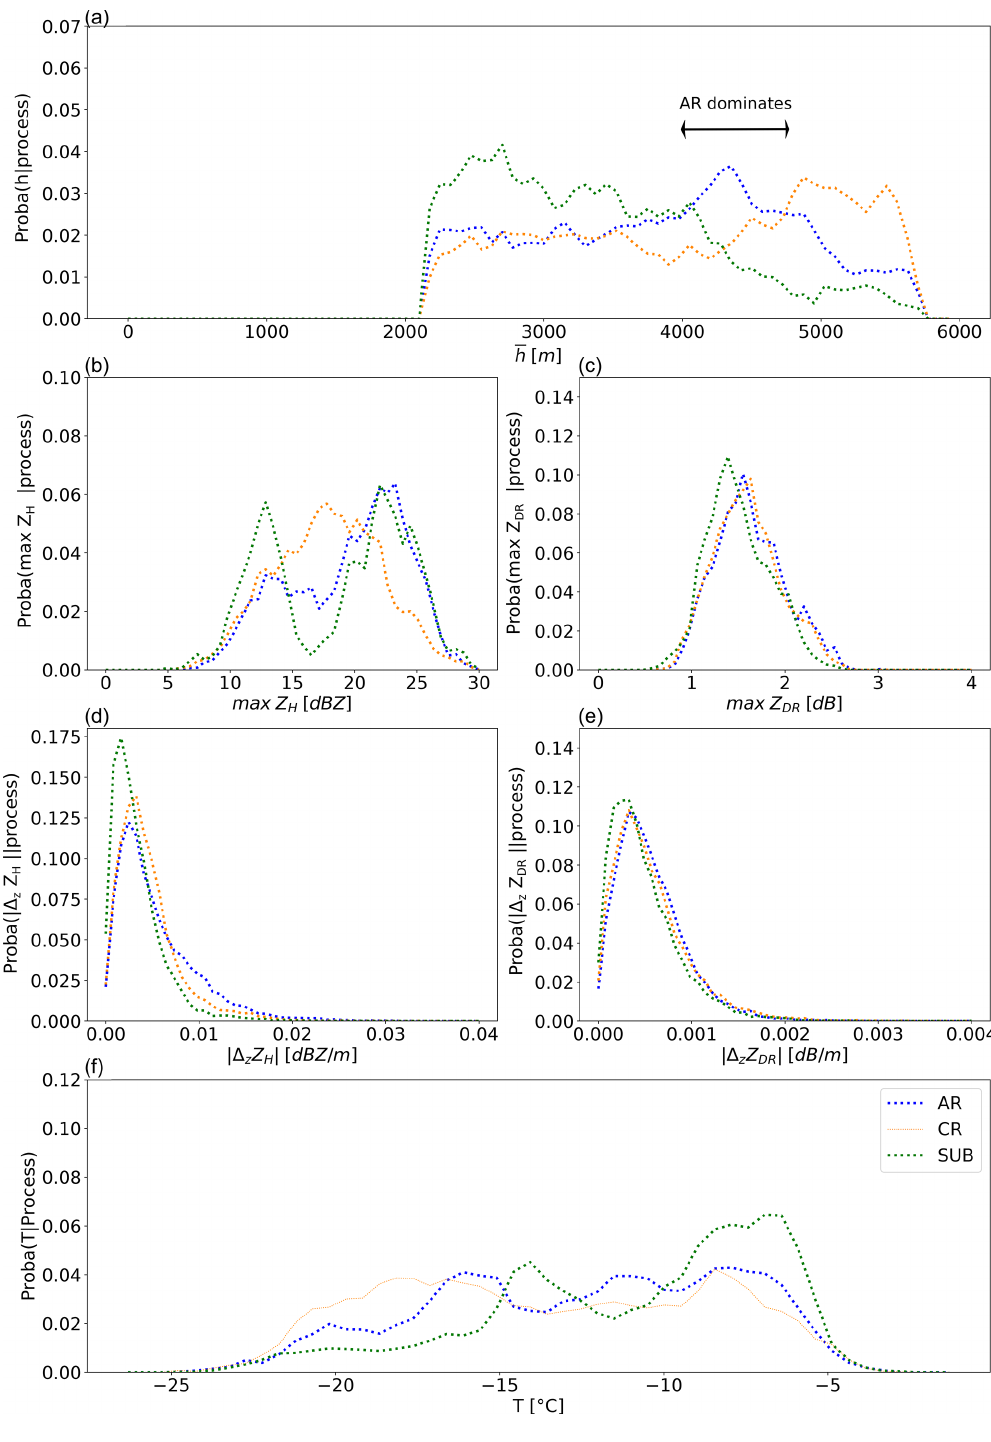
Figure 8. Same as Fig. 7 for